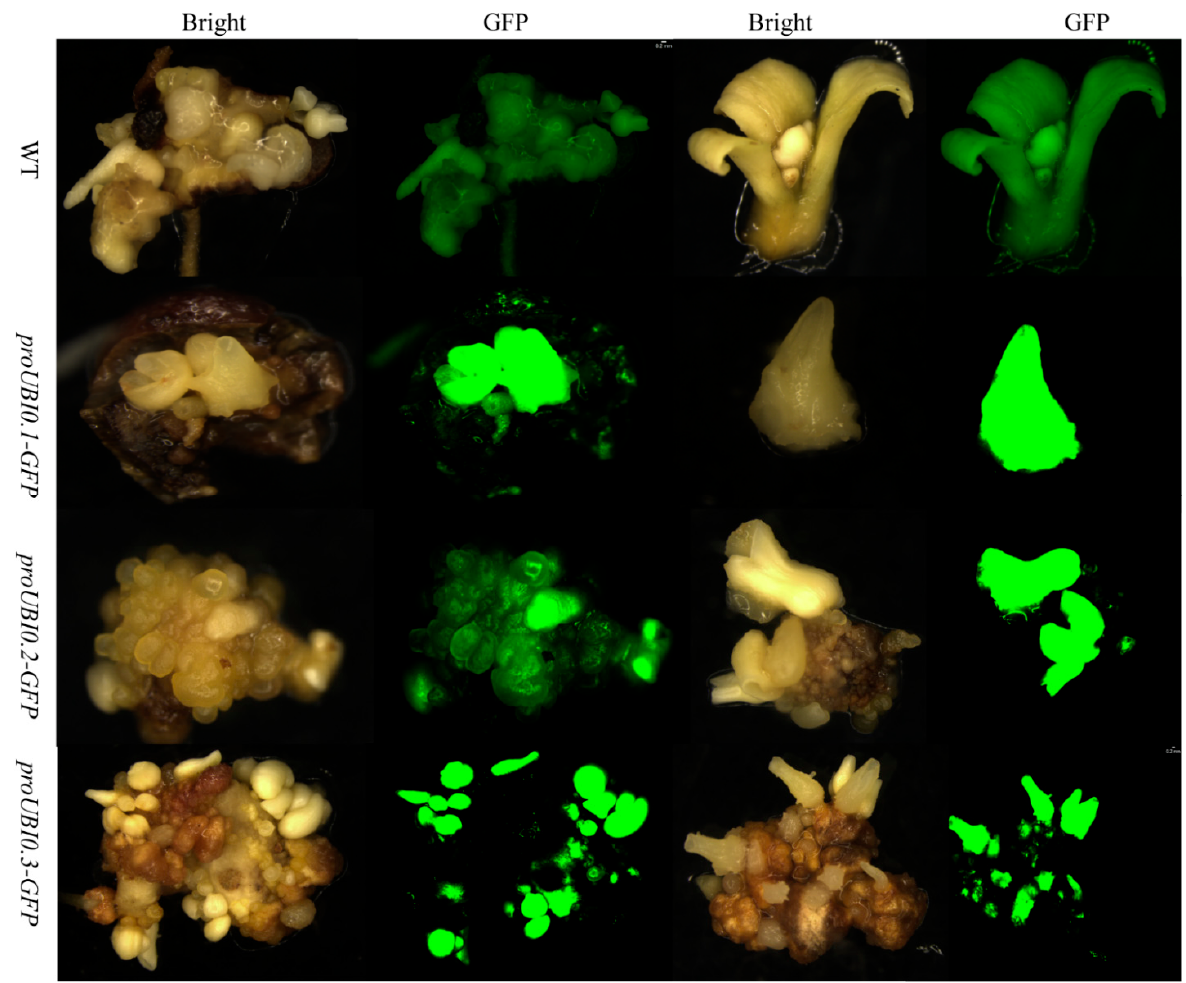
Figure 5. Transgenic Hevea embryos bearing a GFP reporter gene that was respectively driven by HbUBI10.1, HbUBI10.2 and HbUBI10.3 promoters. Non-transformed embryos were used as nega- tive controls.